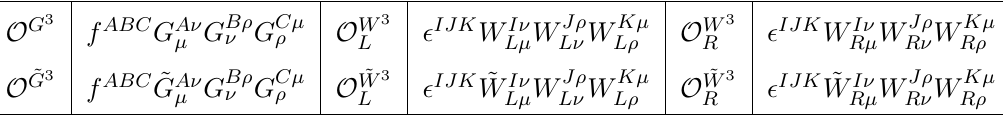
Table 17. MLRSM: X 3 [6] class of operators.